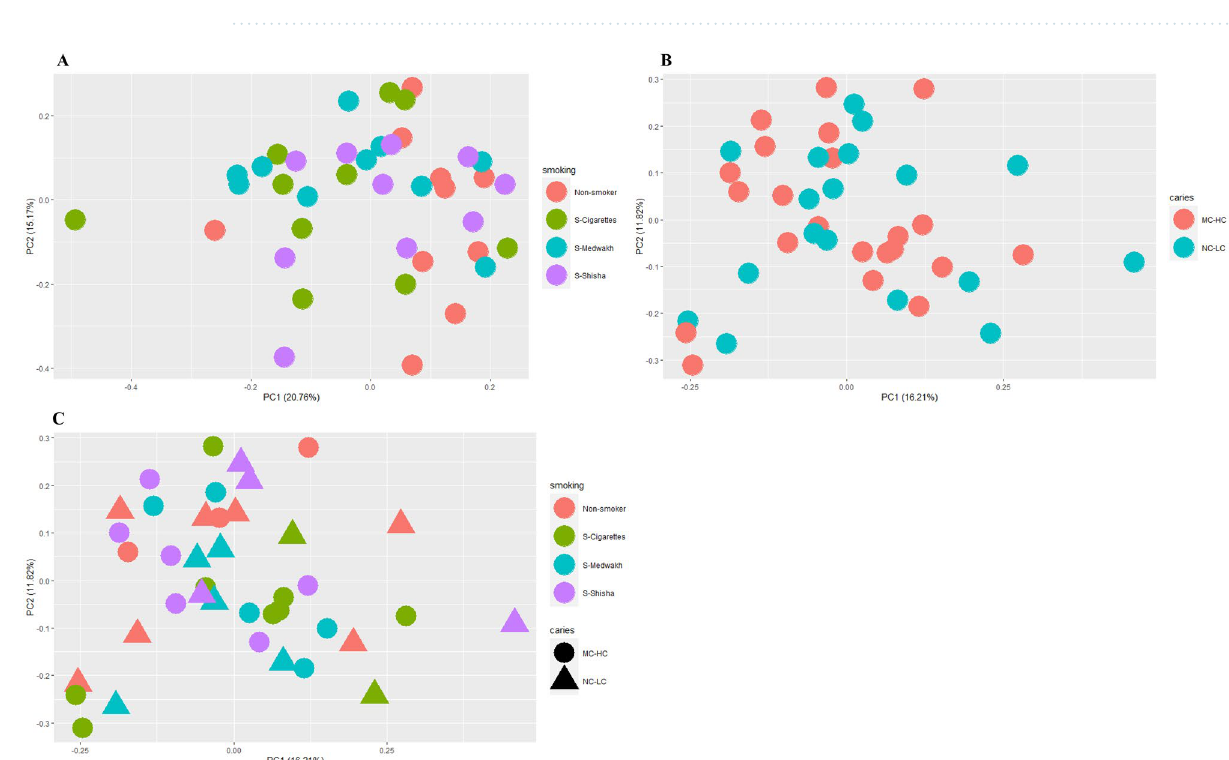
Figure 8. Principal component analysis of the 40 supragingival plaque samples grouped based on type of tobacco smoking ( A ) and dental caries ( B ). Each dot represents a microbial community from one sample. Samples grouped based on both tobacco smoking type and dental caries are shown in ( C ), in which; tringles represent the NC-LC samples and circles represent the MC-HC